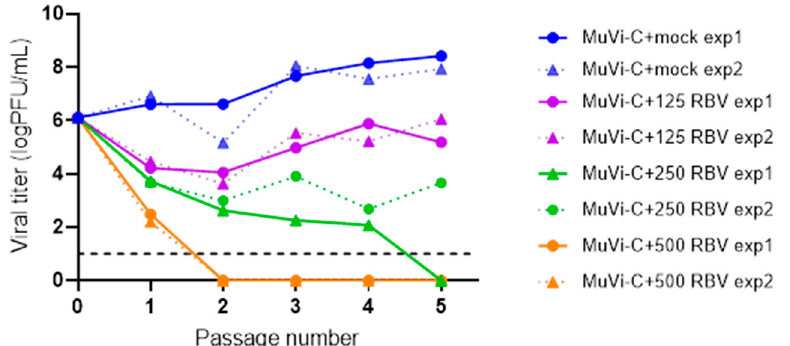
Figure 4. Passaging of MuVi-C in Vero cells treated with different concentrations of RBV. Vero cells were treated with different concentrations of RBV or mock-treated, infected with MuVi-C at MOI 0.001, and then, RBV or medium only were added for an additional 72 h. Titres in supernatants were determined using the plaque assay, and they were further used for subsequent passage at MOI 0.001 in the same conditions. A cutoff value of the plaque assay is shown by a black, dashed line.